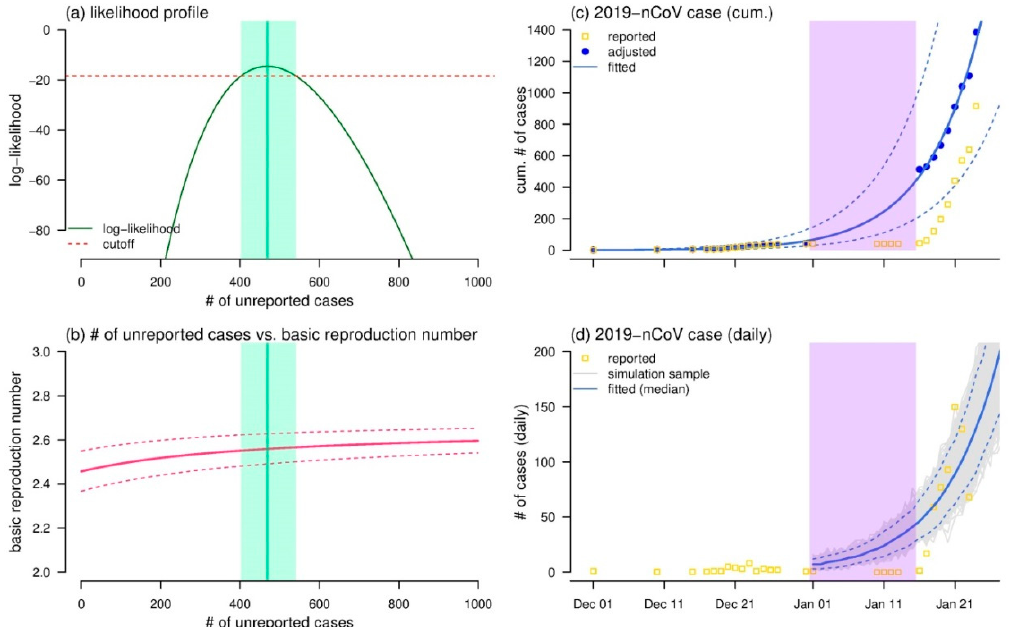
Figure 1. The estimates of the unreported cases between 1 and 15 January 2020, the basic reproduction number ( R 0 ), and fitting results of the number of 2019-nCoV cases time series. Panel ( a ) shows the likelihood profile ( ℓ , dark green curve) of the estimated number of unreported cases ( ξ ), and the cutoff threshold (horizontal red dashed line) for the 95% CI. The relationship between the number of unreported cases ( ξ ) and R 0 , where the bold curve is the mean estimation, and the dashed curves are the 95% CI of estimated R 0 . In panels ( a ) and ( b ), the green shading area represents the 95% CI (on the horizontal axis), and the vertical green line represents the maximum likelihood estimate (MLE) of the number of unreported cases. With the MLE of R 0 at 2.56, panels ( c ) and ( d ) show the exponential growth fitting results of the cumulative number of cases ( C i ) and the daily number of cases ( ε i ) respectively. In panels ( c ) and ( d ), the gold squares are the reported cases, the blue bold curve represents the median of the fitting results, the dashed blue curves are the 95% CI of the fitting results, and the purple shading area represents the time window from 1 to 15 January 2020. In panel ( c ), the blue dots are the cumulative total, i.e., reported and unreported, number of cases. In panel ( d ), the grey curves are the 1000 simulation samples.